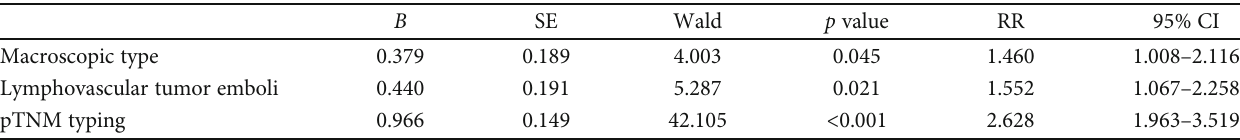
Table 6: Multivariate analysis of tumor characteristics and recurrence and metastasis of upper gastric